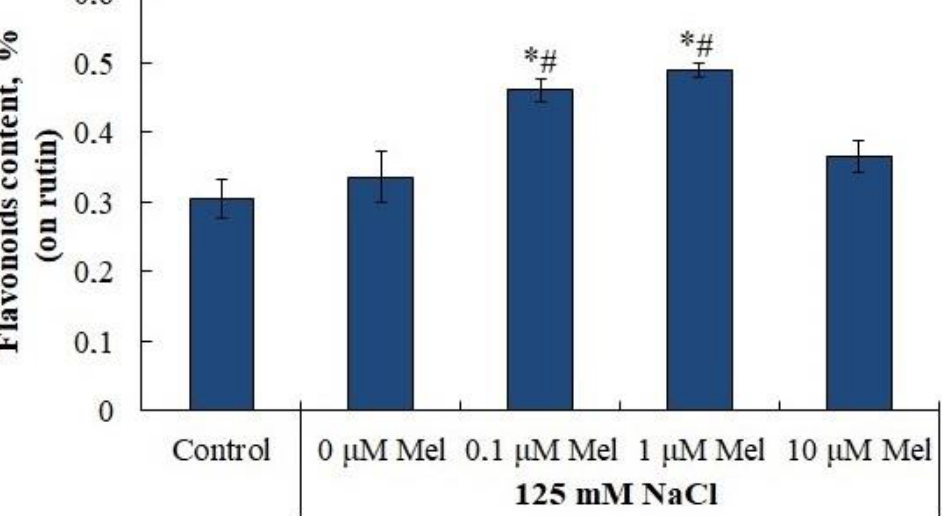
Figure 9. Influence of melatonin and chloride salinity on flavonoids content in Solanum tuberosum leaves. Asterisks (*) indicate significant differences from the control variant and the «#» indicates significant differences from the «125 mM NaCl» variant ( p < 0.05).